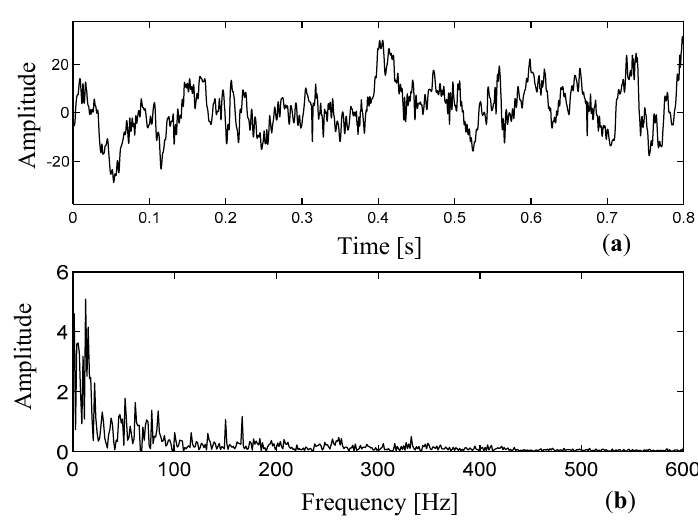
Figure 32. The time domain waveform ( a ) and the FFT spectrum ( b ) of the residual signal. The wavelet analysis was applied to decompose the residual signal. Kurtosis values of the wavelet packets and IWPs generated from the residual signal are calculated and shown in Figure 33.